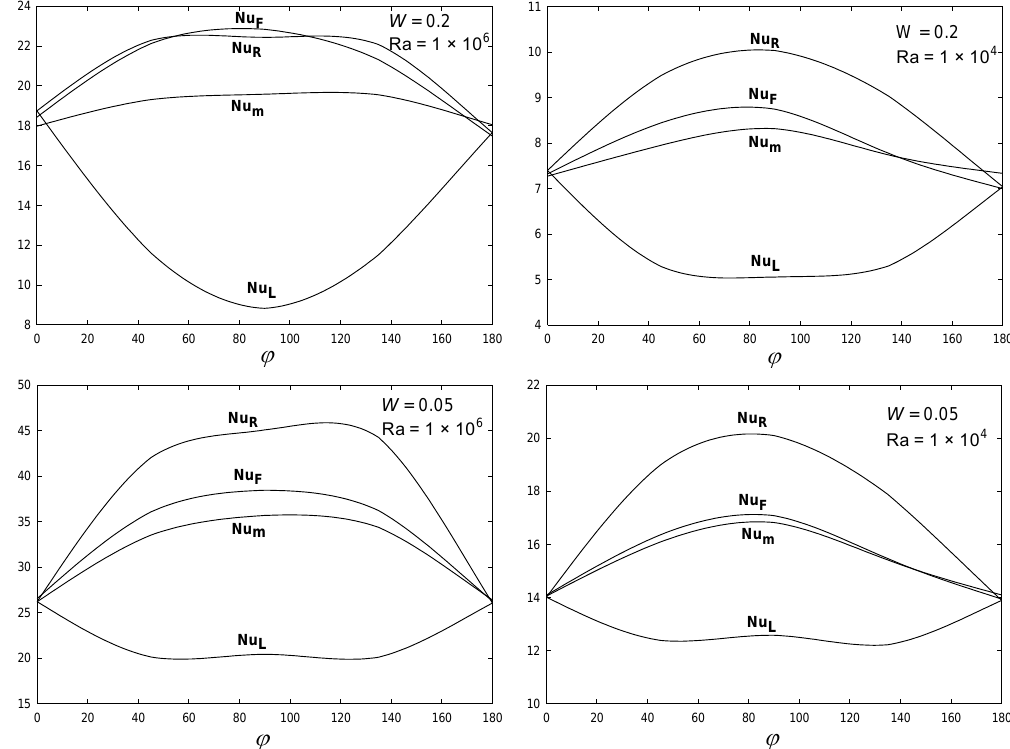
Figure 19. Variations in the mean, front, right-side, and left-side surface Nusselt numbers for a slender cuboid at inclina- tions φ for Rayleigh numbers of Ra = 1 × 10 4 and Ra = 1 × 10 6 , and for W = 0.2 and W = 0.05.